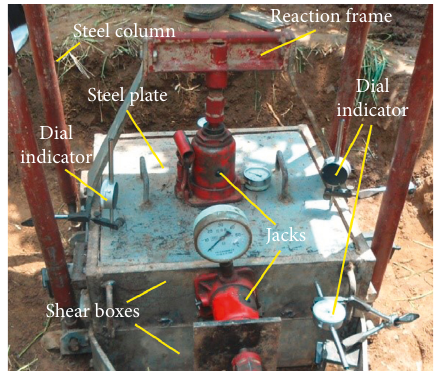
Figure 3: In situ direct shear test equipment.